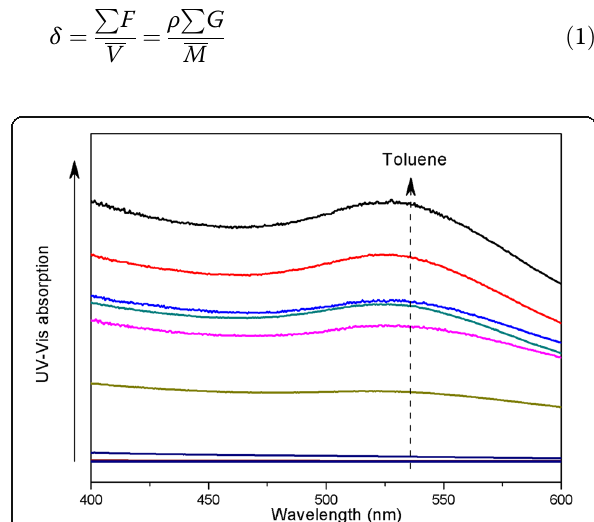
Fig. 7 UV-Vis absorption curves for saturated solutions of Au@DSHPG-2 in different mixtures of toluene and acetonitrile. The dashed arrow indicates the increasing volume fraction of toluene from 0 to 1 with 0.1 interval